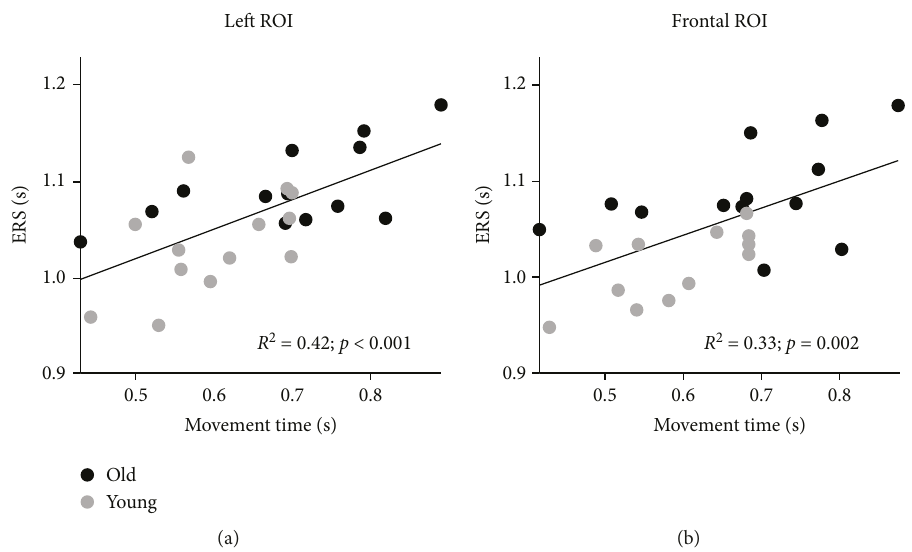
Figure 5: Correlations of total movement time with ERS peak latency in the left (a) and frontal (b) ROIs for younger (gray points) and older (black points) subjects